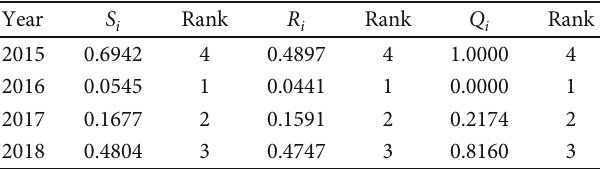
R Q i , i , and i value of economic subsystem.